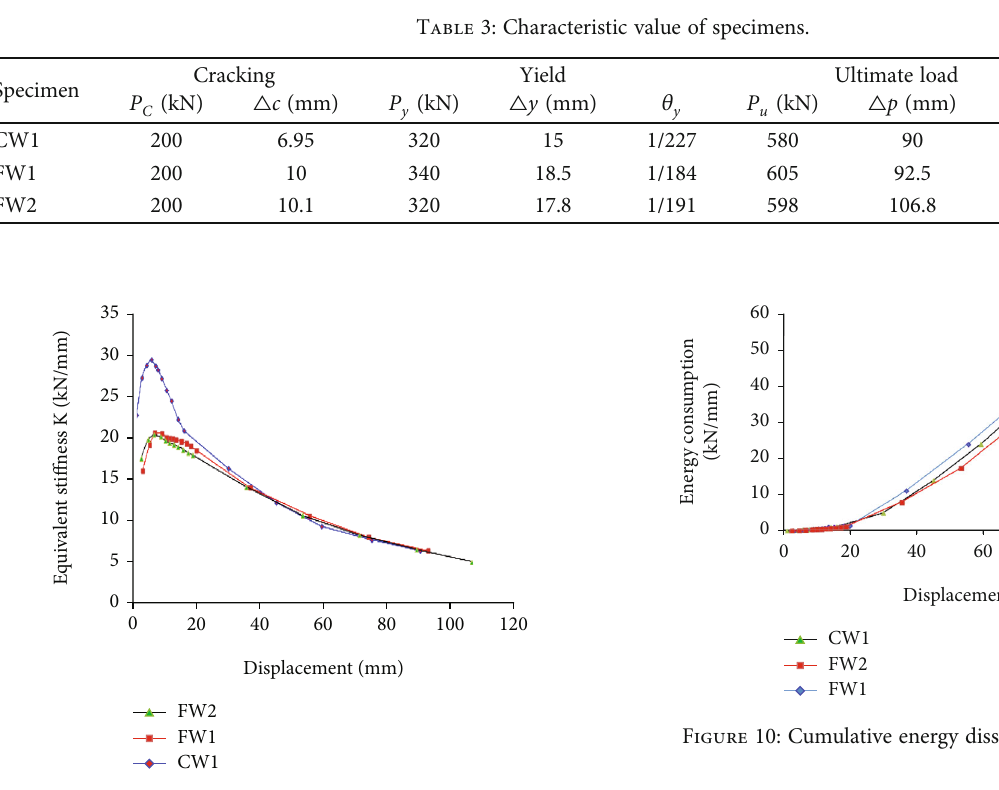
Figure 9: Sti ff ness degradation.